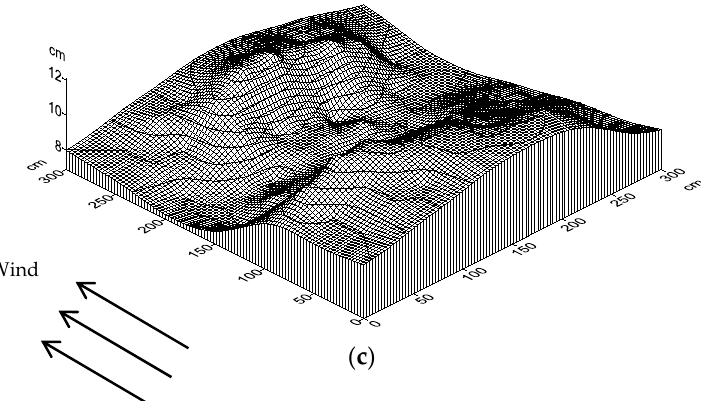
Figure 6. Surface erosion and sediment deposition in checkerboards with different lengths. ( a ) 1 m, ( b ) 2 m, ( c ) 3 m.